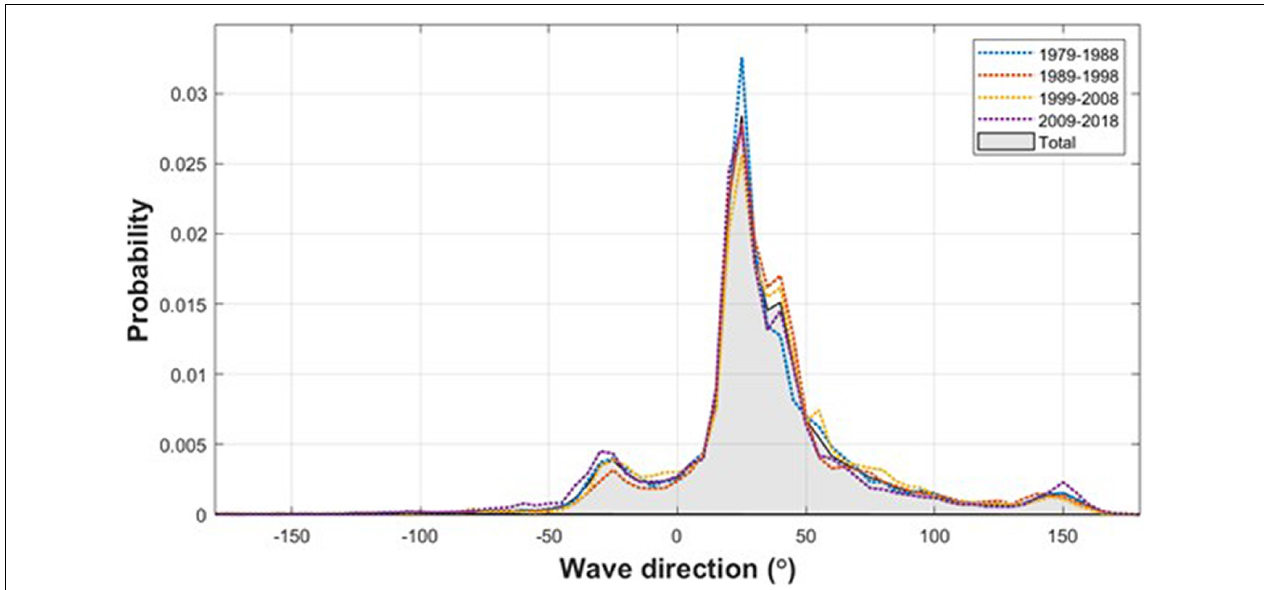
FIGURE 3 | Wave direction distribution at Maengbang coast from the NOAA dataset (1979–2018).